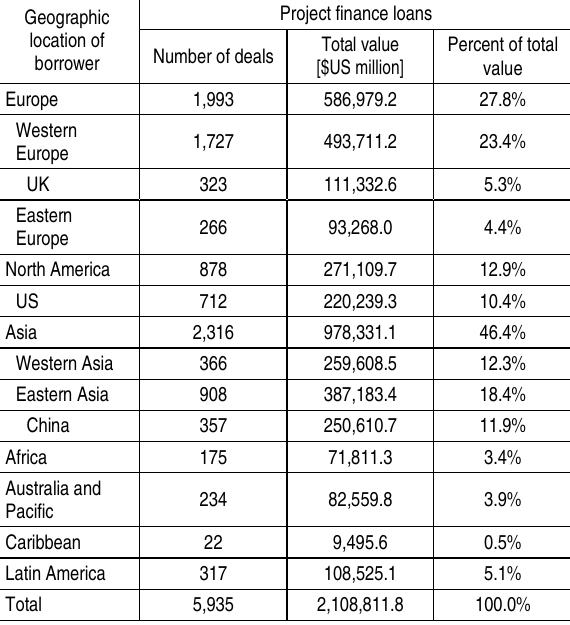
Table 3. Geographic distribution of the